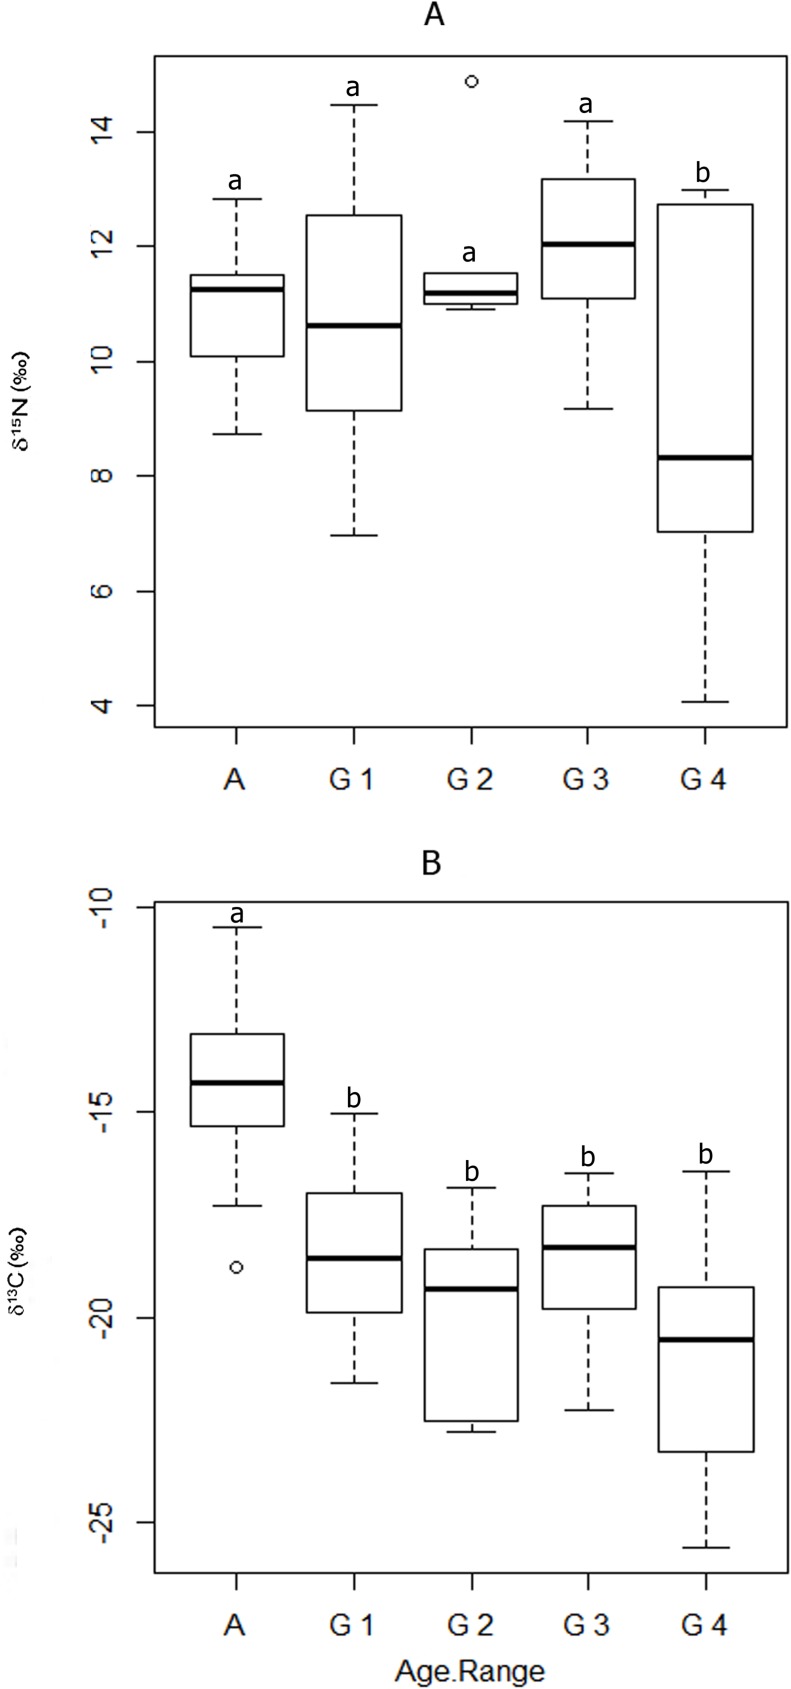
δ15N and δ13Ccol isotopic values among age ranges.Different letters show statistically significant differences. A: Adult, G 1: Group 1, G 2: Group 2, G 3: Group 3, G 4: Group 4.